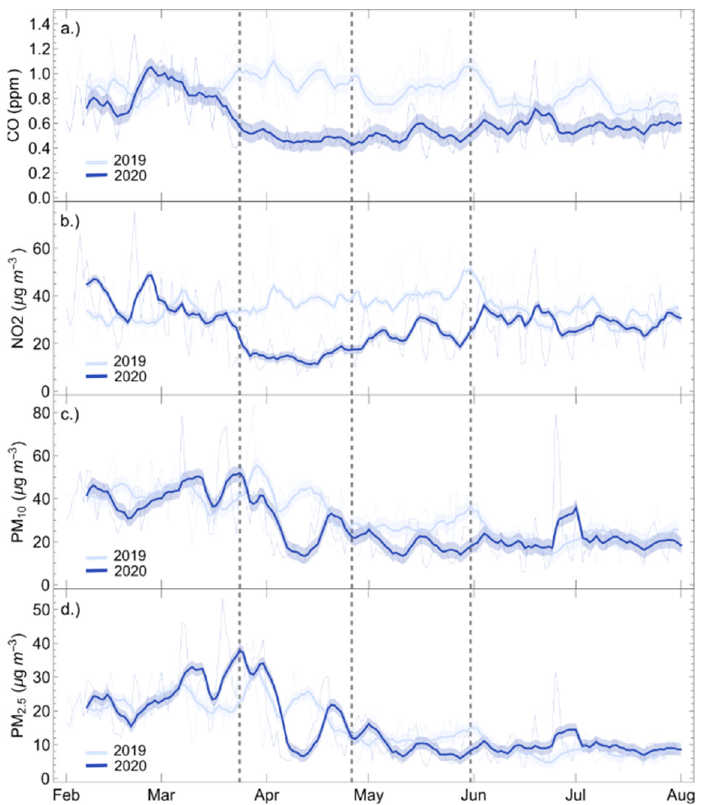
Figure 3. Air quality timeline: ( a ) daily average concentrations of carbon monoxide (CO); ( b ) nitrogen dioxide (NO 2 ) concentrations; ( c ) the first panel corresponds to concentrations of particulate matter below 10 microns (PM 10 ); ( d ) particulate matter below 2.5 microns (PM 2.5 ). The light blue series shows moving concentrations in 2019 and the dark blue series shows concentrations in 2020.